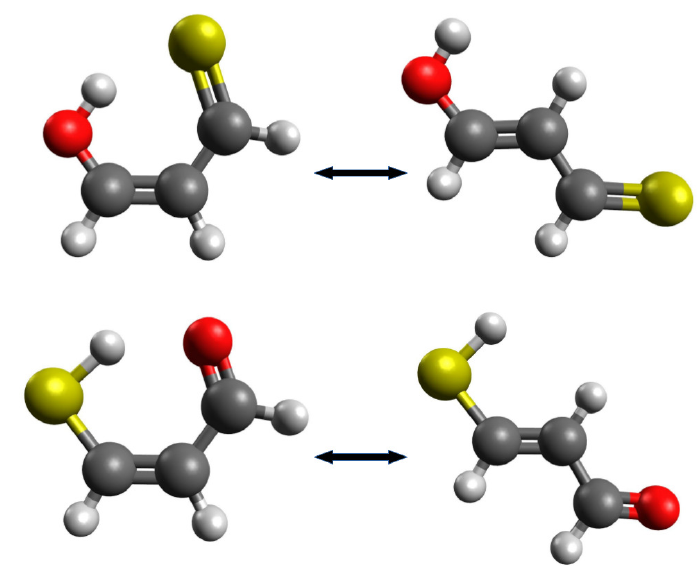
Figure 4. Closed and the most extended enol and enethiol forms of thiomalondialdehyde.